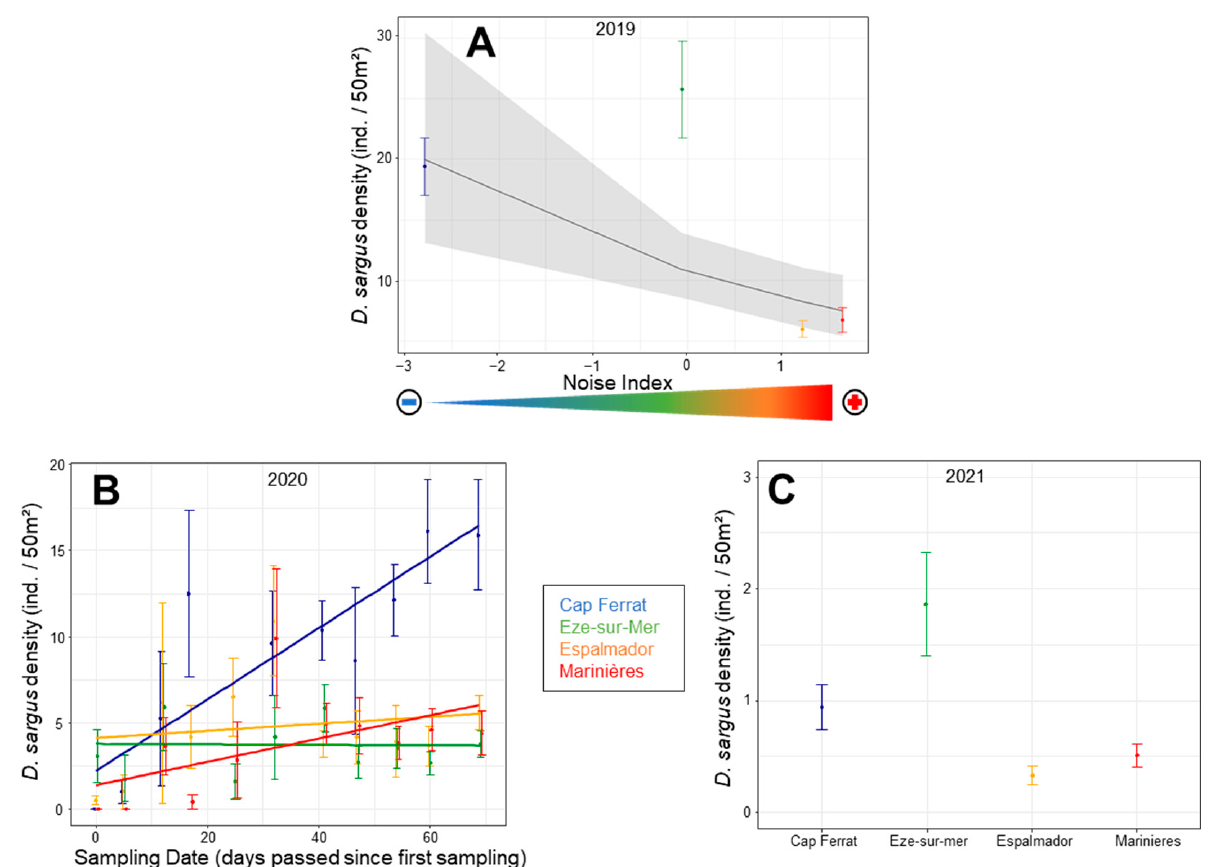
Figure 4. Mean ( ± SE) density values of D. sargus juveniles for the NI levels in 2019 ( A ), and the sampling days for each location in 2020 ( B ) and for each location in 2021 ( C ), according to the results of the glmm models. In ( A ), the line and the grey area are the fitted values and the 95% confidence interval of the regression model. The arrow represents the MNP gradient as in Figure 2. In ( A , C ), the mean and SE are averaged across sampling days, transects and sites. In ( B ), they are averaged across sites.